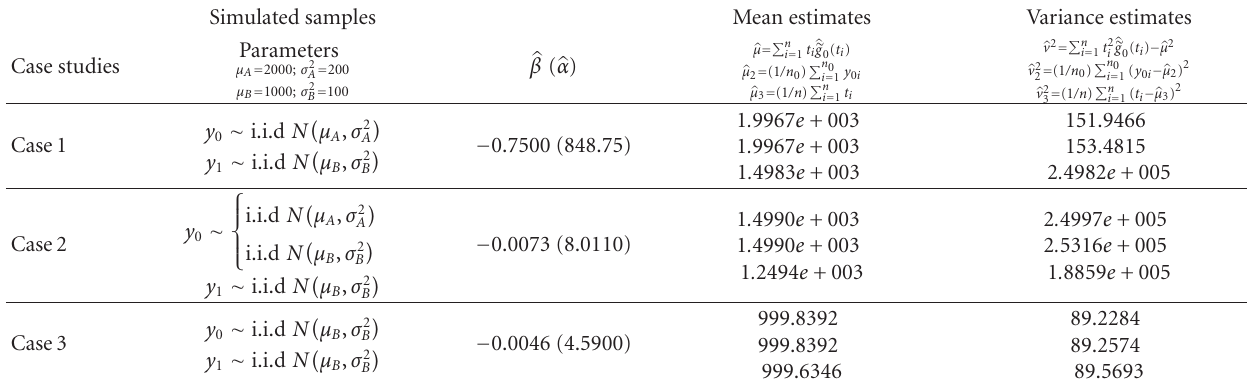
Table 3: Behavior of (cid:29) β on di ff erent case